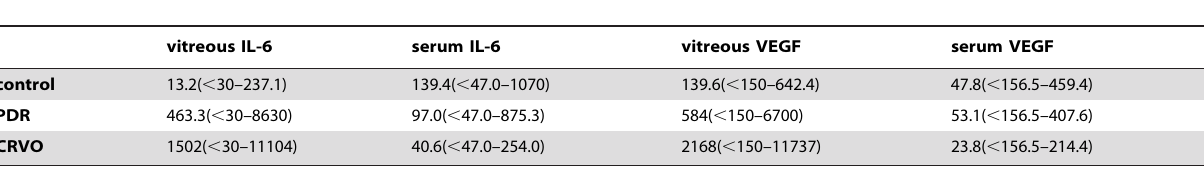
Table 5. Concentrations of IL-6 and VEGF in the vitreous and